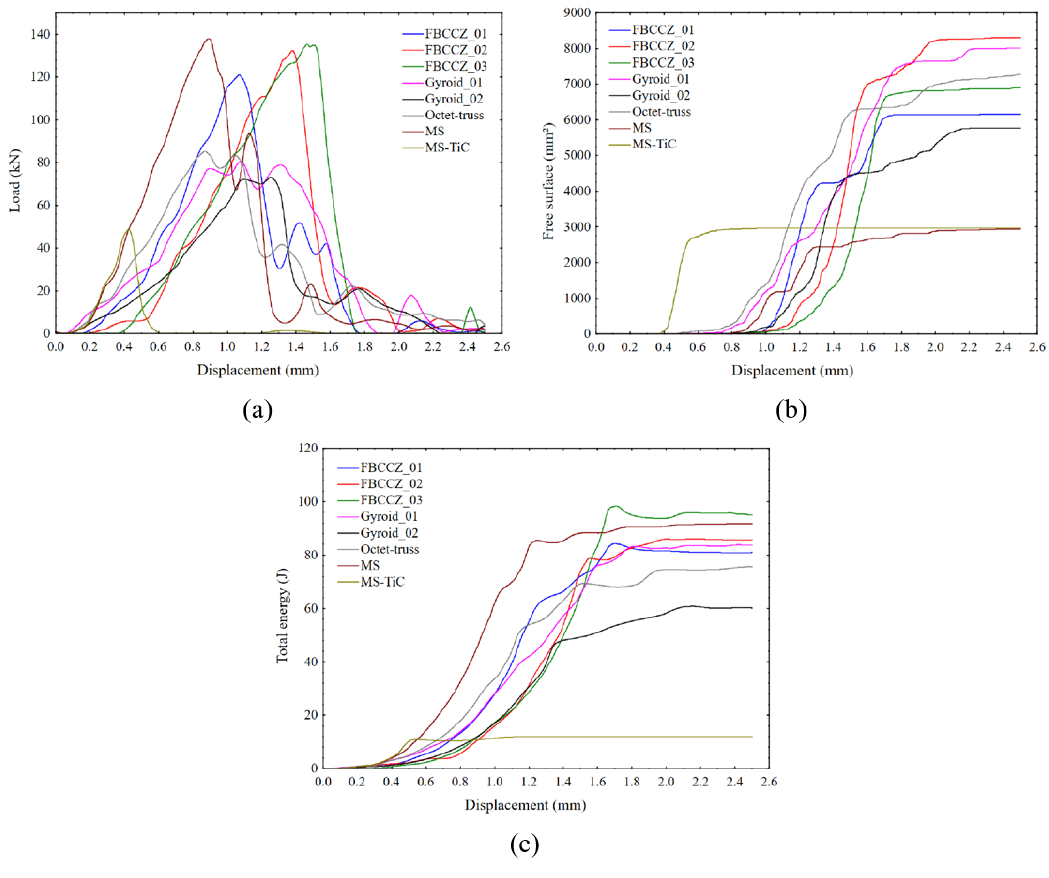
Figure 10. Load ( a ), broken surface in the CT specimen ( b ) and total absorbed energy ( c ), versus